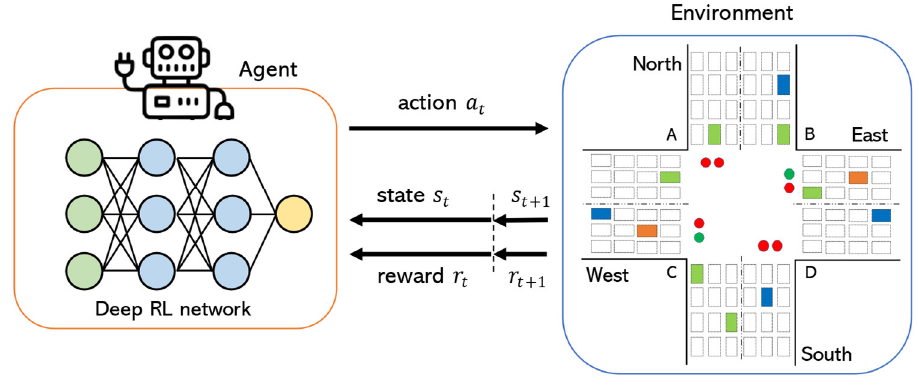
Figure 1. Deep reinforcement learning model for traffic light control.